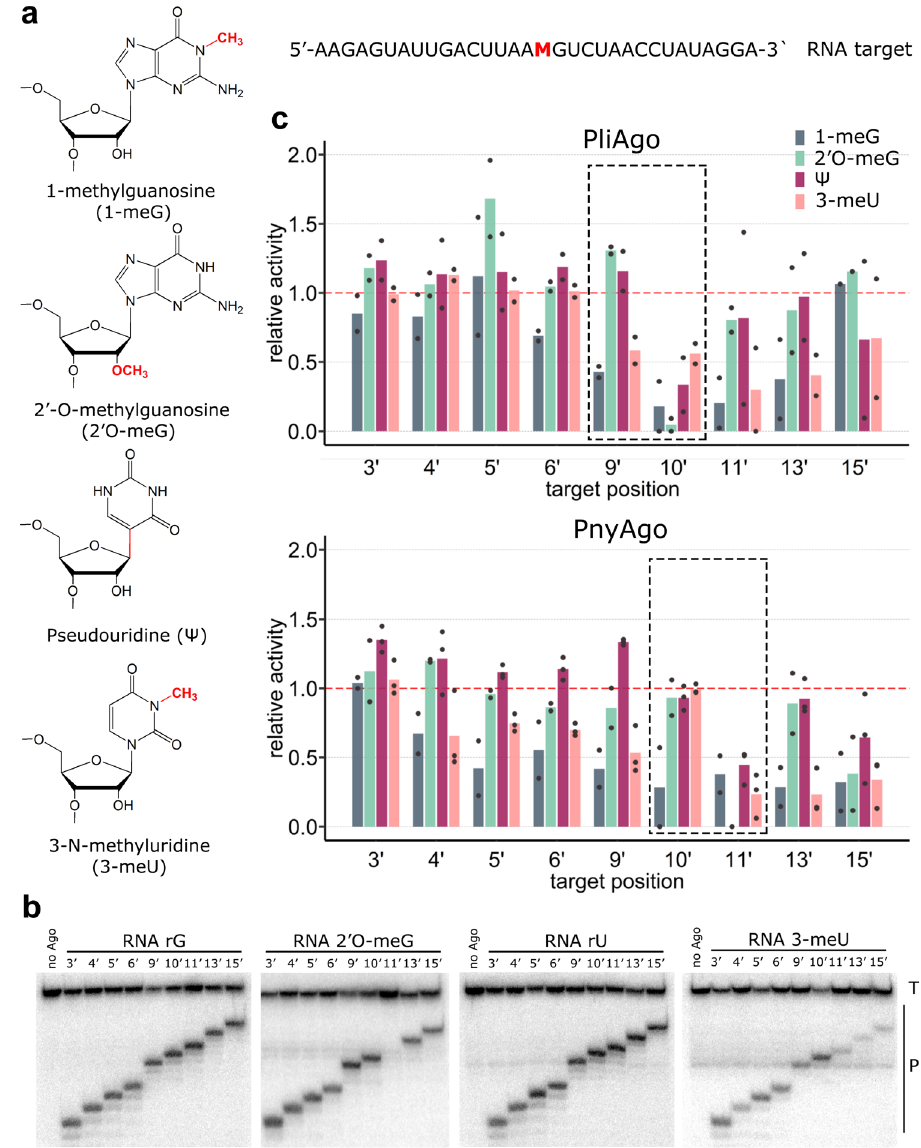
Fig. 5 | D-R pAgos sense RNA modi fi cations at speci fi c target positions. a Modi fi ed nucleotide residues with detected effects on the target RNA cleavage. ThetargetRNAsequenceisshownontheright(M,modi fi ednucleotide),theguides are shown in Supplementary Fig. 8a. b Cleavage of modi fi ed RNAs containing 2 ’ O- meG or 3-meU at the indicated positions by PnyAgo in comparison with control RNAs(rGorrU).Representativegelsfrom2or3independentexperiments. c Effects